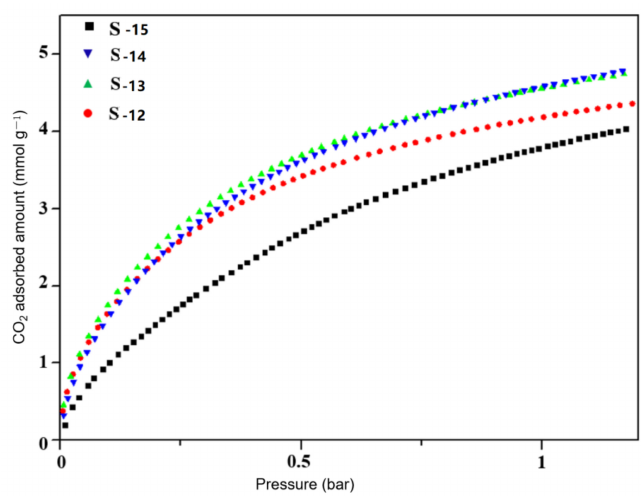
Figure 12. CO 2 adsorption isotherm of samples S-12, S-13, S-14 and